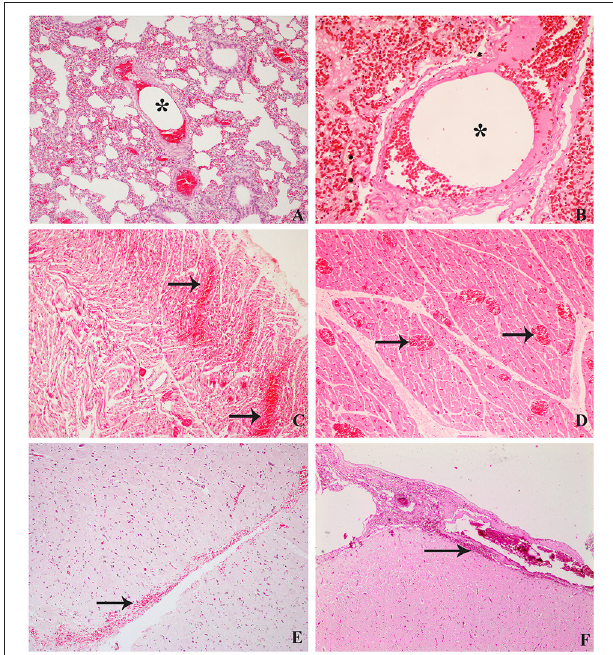
FIGURE 3 | Histological findings compared between decompression sickness in rabbits (left row) and cetaceans (right row) stained routinely with hematoxylin–eosin. (A) C/D mortality rabbit. Intravascular bubble-like round empty space among blood cells (black star), mild emphysema, and congestion in pulmonary areas. (B) Risso’s dolphin, × 10. Microscopic bubble-like cavities circulating within a pulmonary blood vessel (black star). (C) C/D mortality rabbit, × 20. Multifocal hemorrhages (black arrows) and congestion of cardiac capillaries. (D) Risso’s Dolphin, × 10. Presence of congestive capillaries in cardiac tissue (black arrows). (E) C/D mortality rabbit, × 20. Hemorrhages in the subarachnoid area of the central nervous system. (F) Beaked whale, × 10. Subarachnoid hemorrhages in the central nervous